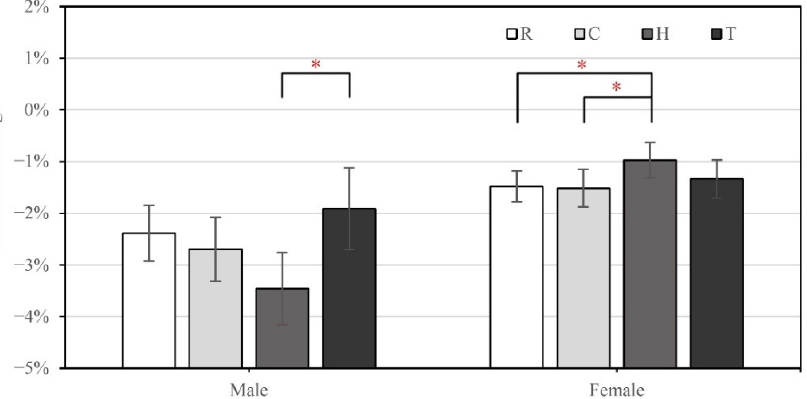
Figure 8. Effect of gender and exposure time on physiological responses to traffic sounds. The ver- tical bars represents 95% confidence intervals.